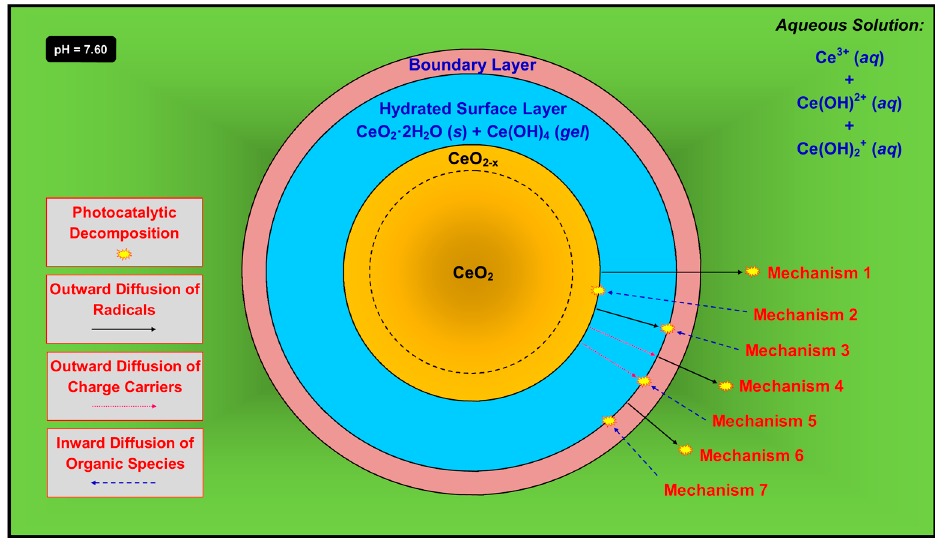
Figure 11. Simplified schematic of the potential mechanisms for the activation of CeO 2 photocatalyst and the decomposition of organic species.